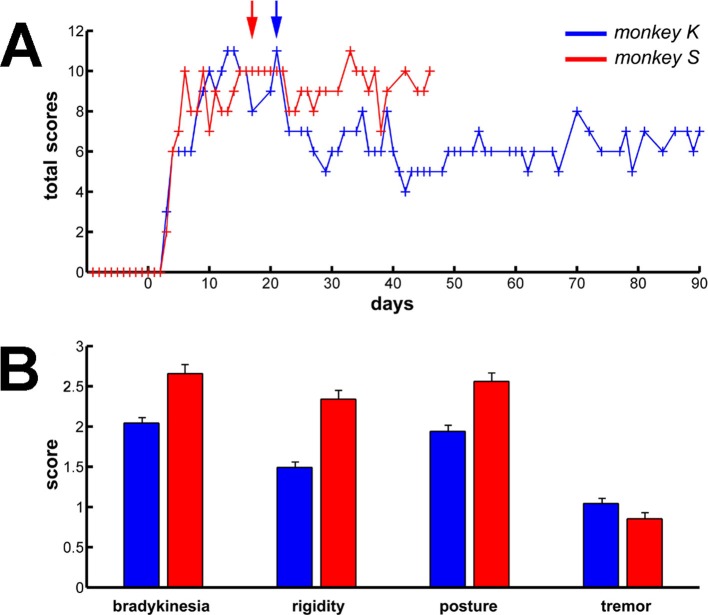
Long term and persistent parkinsonian motor symptoms following MPTP intoxication.(A) Evolution of the sum of the scores of the major parkinsonian motor symptoms (bradykinesia, rigidity, posture and tremor) in each monkey before and after MPTP intoxication, up to the completion of the recordings. Day 0 indicates the first MPTP injection. Arrows mark the first day of dopamine-replacement therapy for each monkey. After initiation of dopamine-replacement therapy, scoring of the parkinsonian motor symptoms was made off dopaminergic medication (overnight washout >12 hr). The level of parkinsonism was assessed by using a primate parkinsonism scale that rates each motor parkinsonian symptom (bradykinesia, rigidity, posture and tremor) from 0 (normal) to 3 (severe). Hence, the minimum score is 0 and the maximum is 12. (B) Mean scores for the four motor symptoms (ranges from 0-normal to 3-severe) during the complete recording period in each MPTP-treated monkey. Error bars represent SEMs.